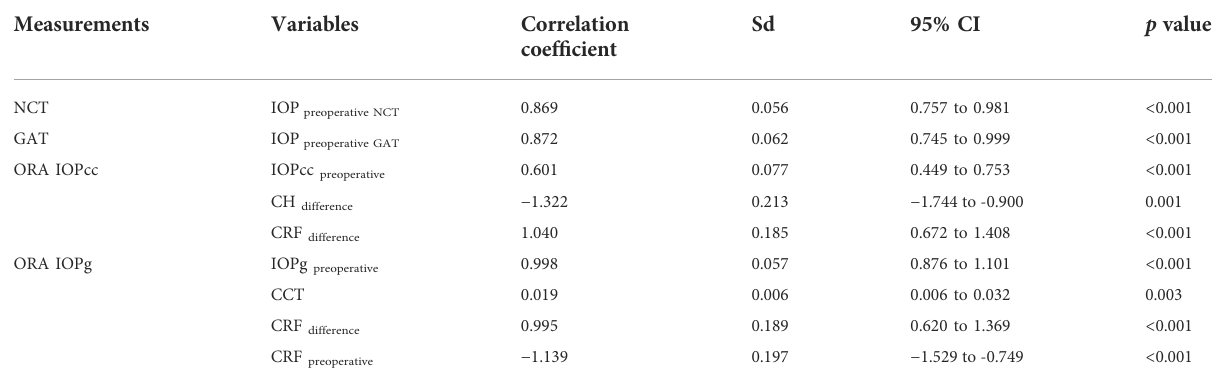
CCT, central corneal thickness; CI, con fi dence interval; CH, corneal hysteresis; CRF, corneal resistance factor.